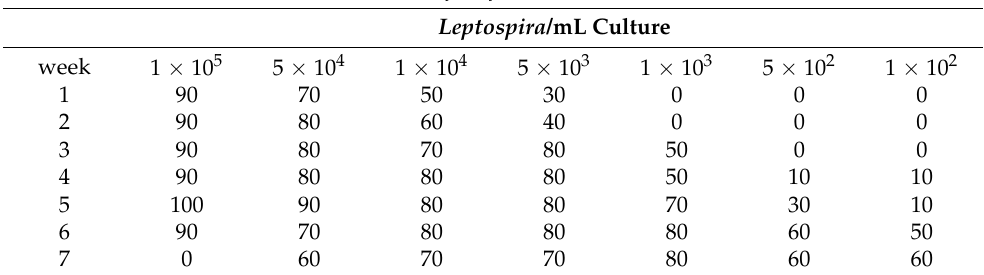
Table 1. Percentage (%) of ten EMJH-STAFF cultures from spiked swine urine samples with mi- croscopically (dark field, 200 × ) detectable Leptospira without contamination at week one to seven weeks post